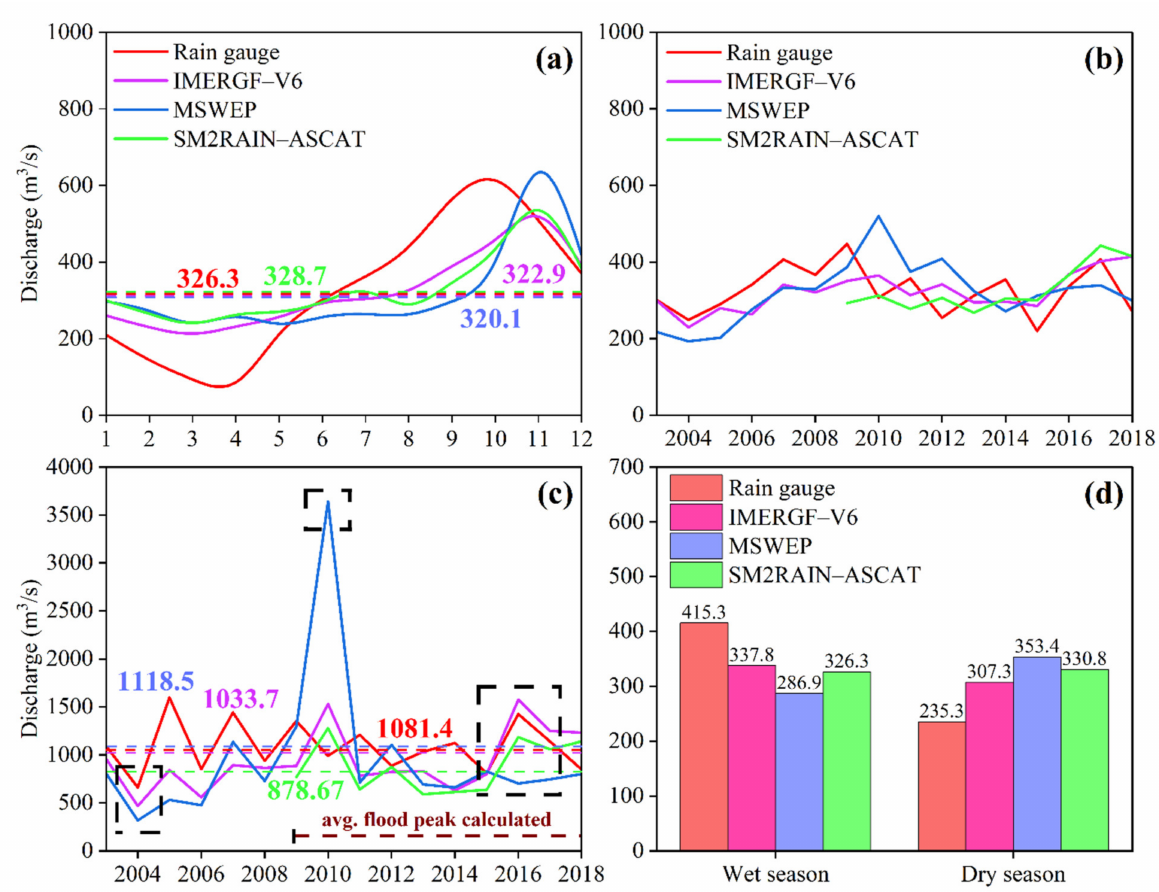
Figure 12. The simulated streamflow for ( a ) monthly, ( b ) yearly, ( c ) flood peak, and ( d ) wet and dry seasons at the SRB outlet. Dashed lines with corresponding colors represent the mean values for each